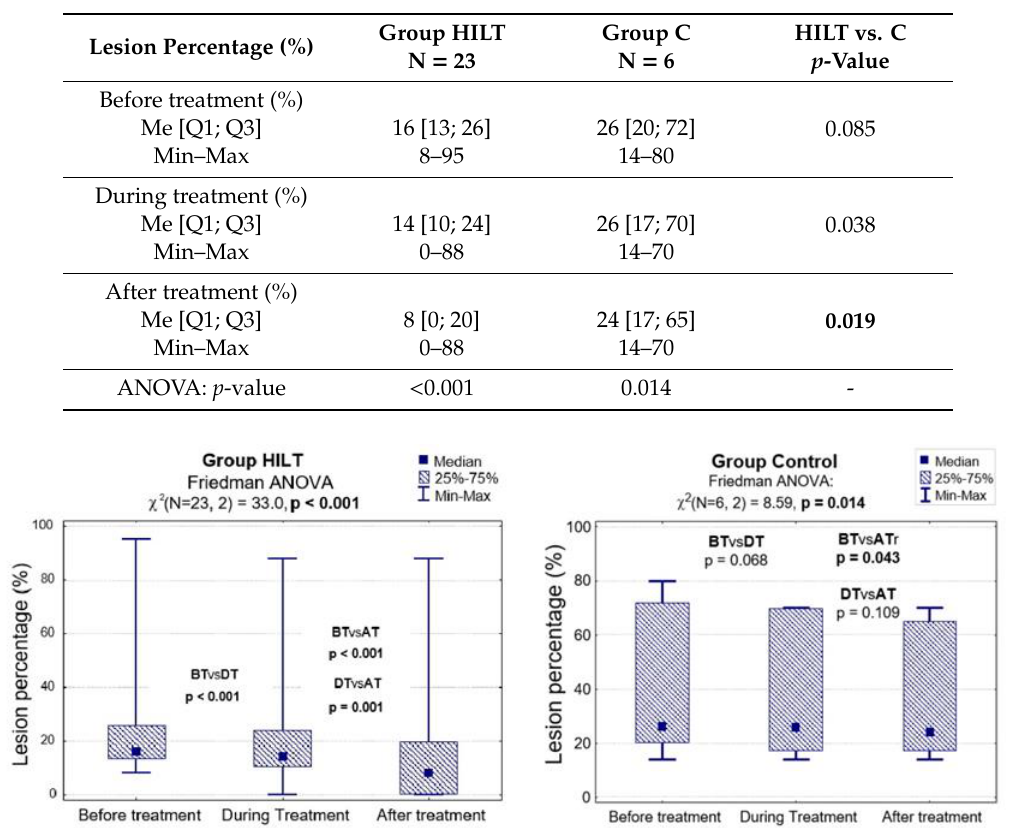
Table 3. The e ff ect of HILT on lesion percentage reduction (median and IQR) for horses from group HILT and group C.